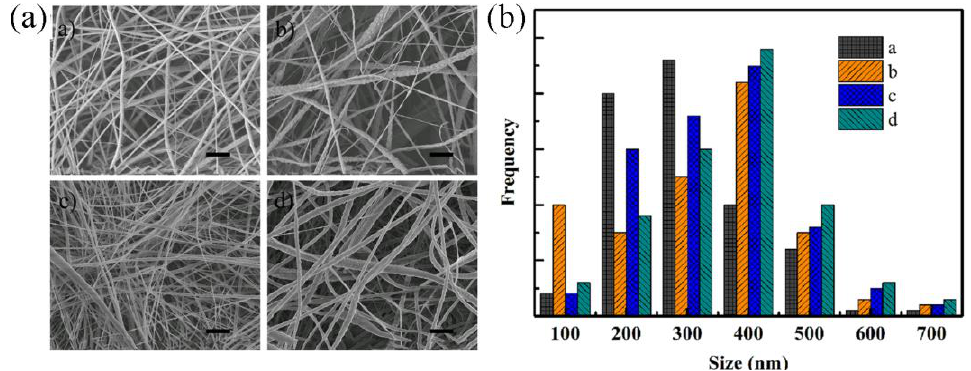
Figure 1. SEM images ( a ) and diameter distribution of the as-electrospun nanofiber ( b ). Naonofiber webs of (a) pure PVDF; (b) 0.5 wt% Ag NWs doped PVDF; (c) 1.5 wt%